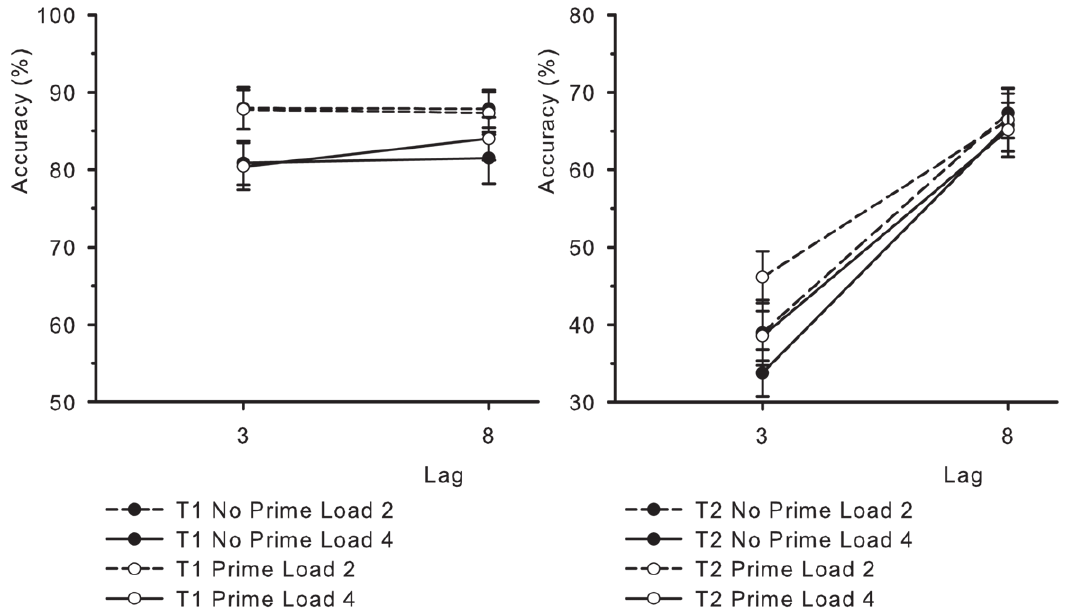
Figure 4. Identification accuracy in percent correct in Experiment 3. The left panel shows T1 performance, and the right panel shows T2 performance, given that T1 was correctly responded to (T2|T1), plotted as a function of T1-T2 Lag. Black symbols represent the condition without priming and white symbols represent the condition with priming. The remaining figure conventions are identical to those of Figure 2.